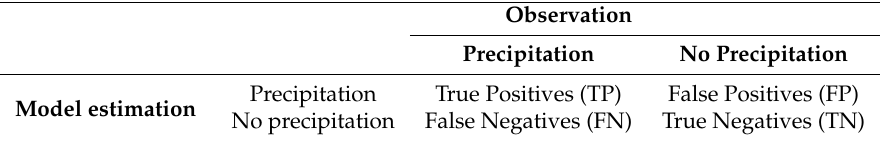
Table 4. Confusion matrix used to calculate the validation measures for the precipitation area delineation [59,60].